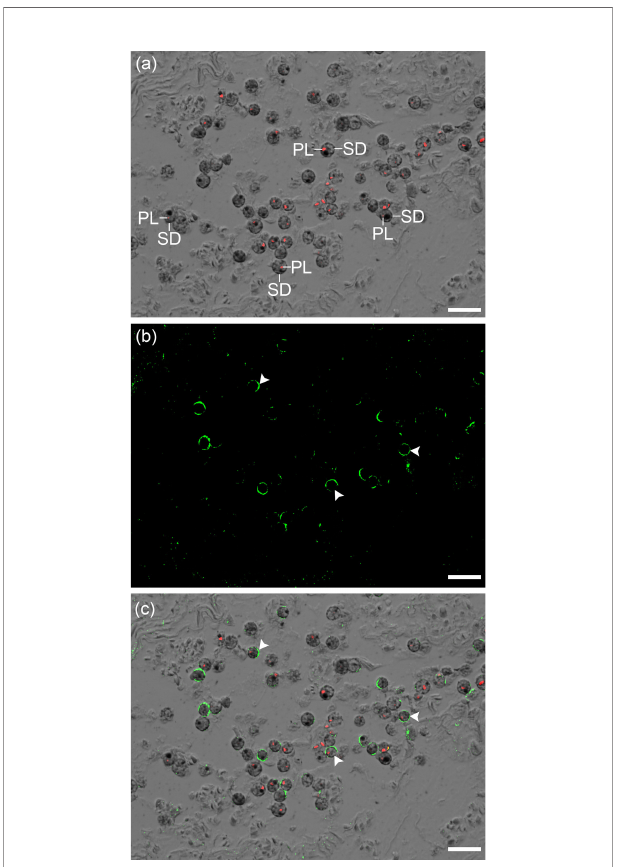
FIGURE 4 | Immuno fl uorescent labelling of zooxanthellae-ammonium transporter 2 (Zoox-AMT2) in the outer mantle of Tridacna squamosa . Zoox- AMT2 comprises AMT2 of Symbiodinium, Cladocopium and Durusdinium . (A) The combined image of differential interference contrast (DIC) microscopy and the red channel showing auto fl uorescence of the plastids (PL) in the coccoid dino fl agellates (SD). (B) The image showing green immuno fl uorescence of Zoox-AMT2. (C) The DIC image overlaid with the red channel and green channel. Arrowheads indicate the localization of Zoox- AMT2 (green) at the plasma membrane of SD. Scale bar: 20 m m. Replicable results were obtained from T. squamosa (n =